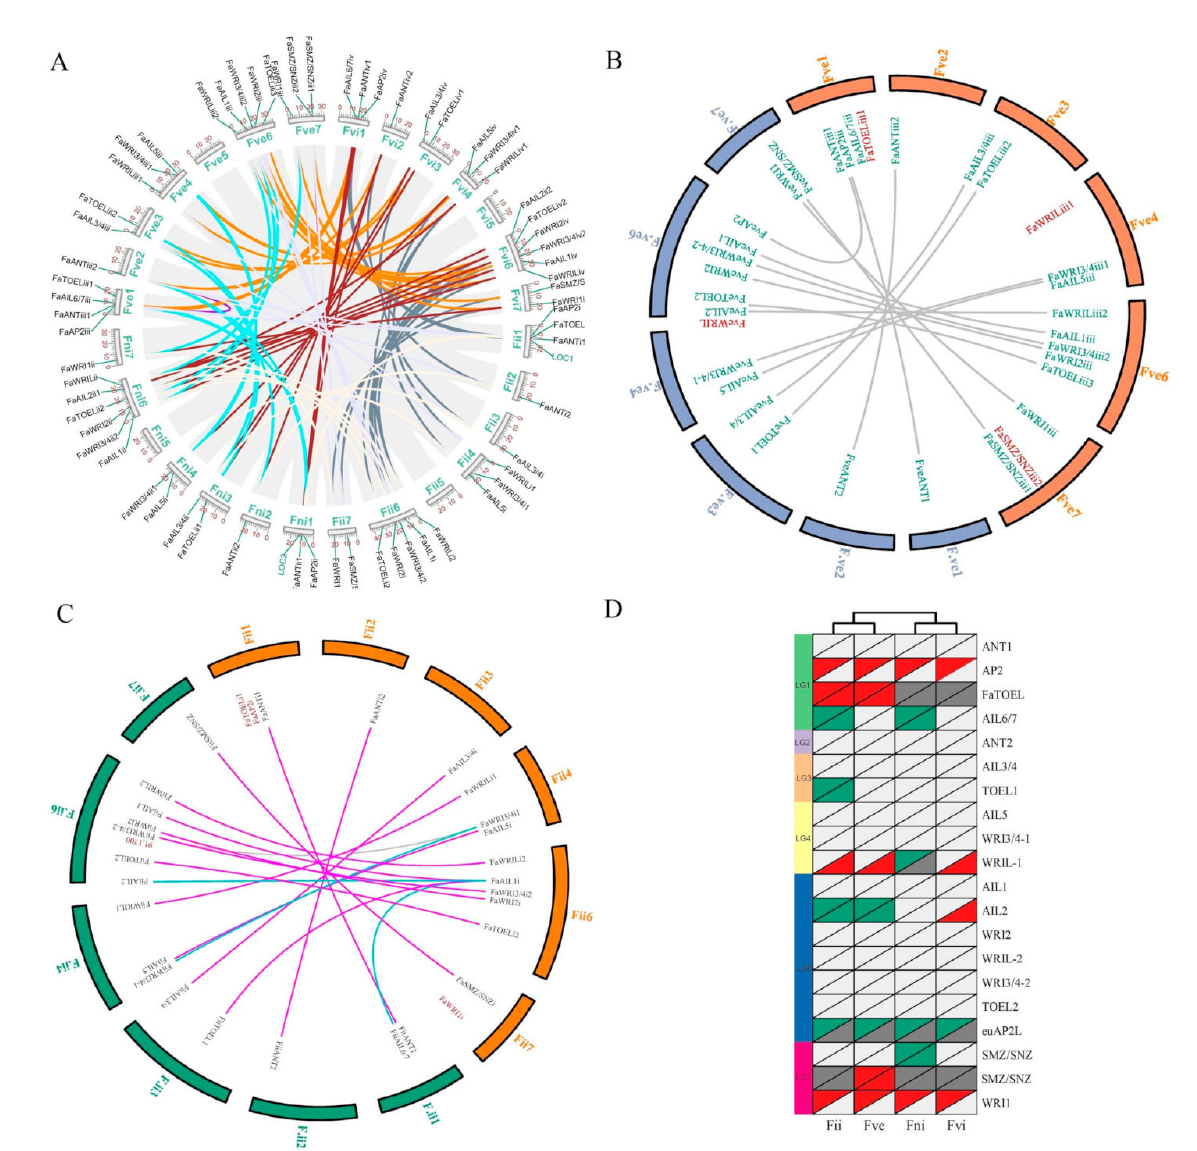
Figure 3. The intra-species and inter-species synteny analysis of the Fragaria × ananassa genome with sub-genome donors. ( A ) The intra-species synteny analysis. Syntenic regions are indicated by dark lines, and paralogous AP2 pairs are highlighted. The 4 sub-genomes are named Fve, Fii, Fni, and Fvi according to sub-genome donors [2]. The 1–7 chromosomes of each sub-genome are arranged in order of the Fni, Fve, Fvi, and Fii sub-genomes. The locations of AP2 genes are mapped by the scale plate value of the chromosomal length. Two green labeled homologous genes, LOC1 and LOC2 , were rejected as AP2 TFs due to a lack of the AP2 domain. ( B ) Synteny analysis of the Fve sub-genome of F. × ananassa with orange color between the Fragaria vesca genome whose chromosomes were named F.ve1–7. The orthologous AP2 pairs are indicated by lines, and unpaired AP2 TFs are red-labeled. ( C ) Synteny analysis of the Fii sub-genome of F. × ananassa with orange color between the Fragaria iinumae genome whose chromosomes were named F.ii1–7. The orthologous AP2 pairs are indicated by lines, and unpaired AP2 TFs are red-labeled. The pair lines supported/unsupported by phylogenetic analysis (Figure S3 and S4) are highlighted with purplish red and blue colors, respectively. ( D ) Deductive gene duplication and loss. Gene loci are listed in 20 rows, and sub-genomes are listed in 4 columns. Red, blue, light gray, and dark gray triangles of the top left indicate gene duplication, gene loss, present shared locus, and absent shared locus compared with F. iinumae AP2 loci, respectively. Low right triangles indicate an F. vesca AP2 loci